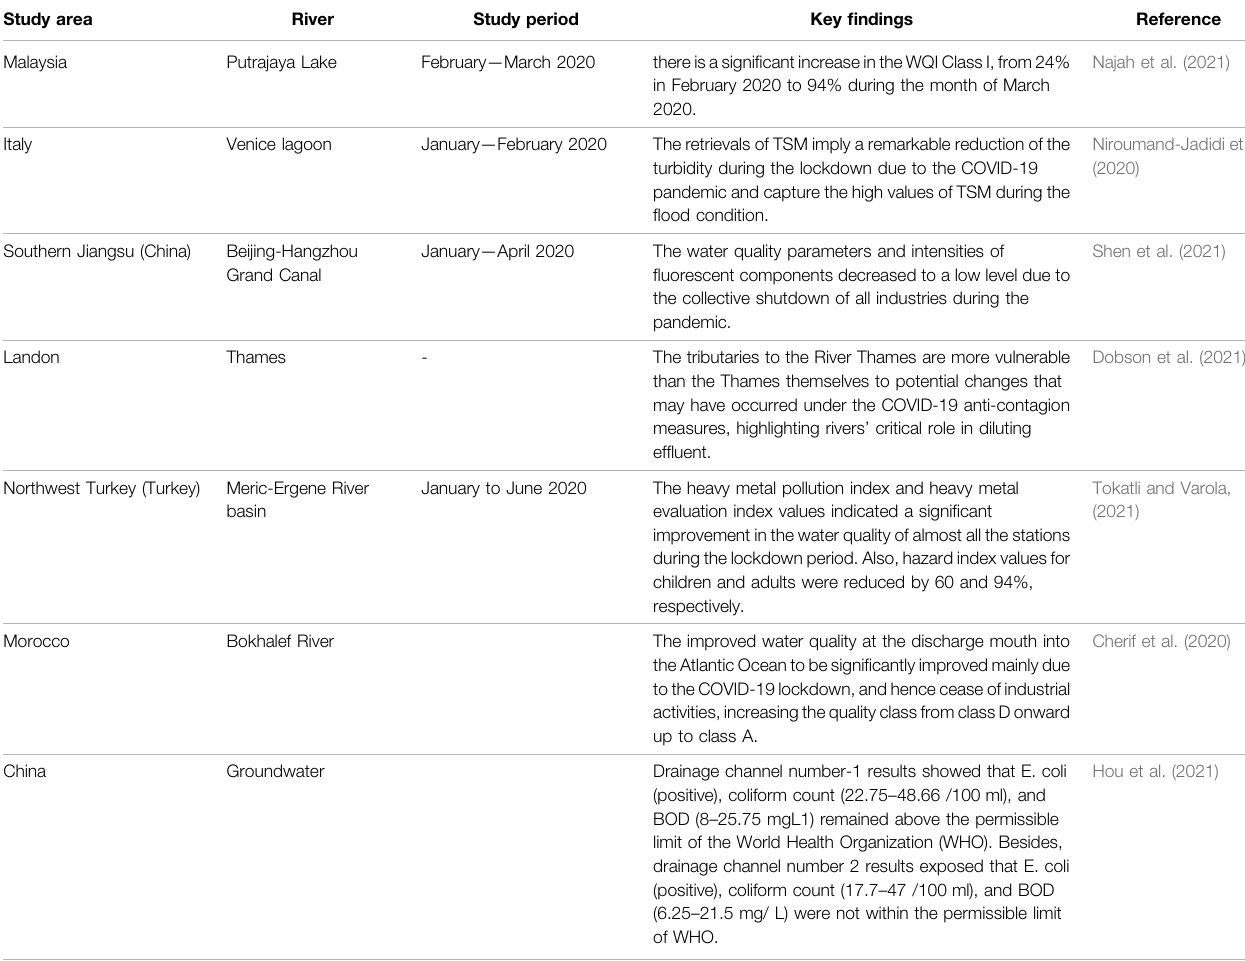
Table S1 ). Haryana ’ s economic activities data were taken from Economic Survey, Haryana,